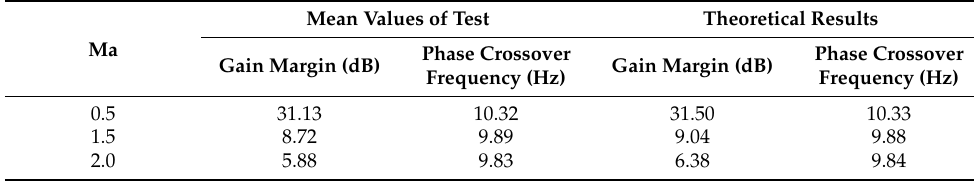
Table 3. Stability margin of the slender vehicle at different Mach numbers (U1C1